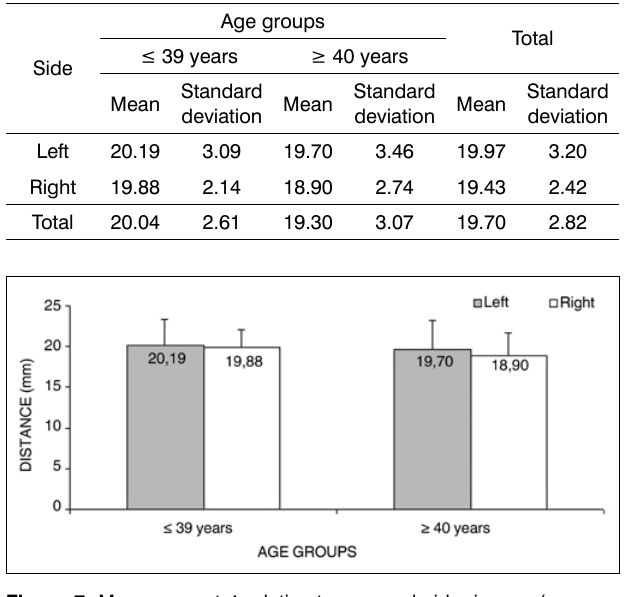
Figure 7. Measurement 4 relative to age and side, in mm (mean ± standard deviation) - measurement 4 (the shortest measurement from the EBSLN to the midline of the neck at the most caudal point of the thyroid cartilage).